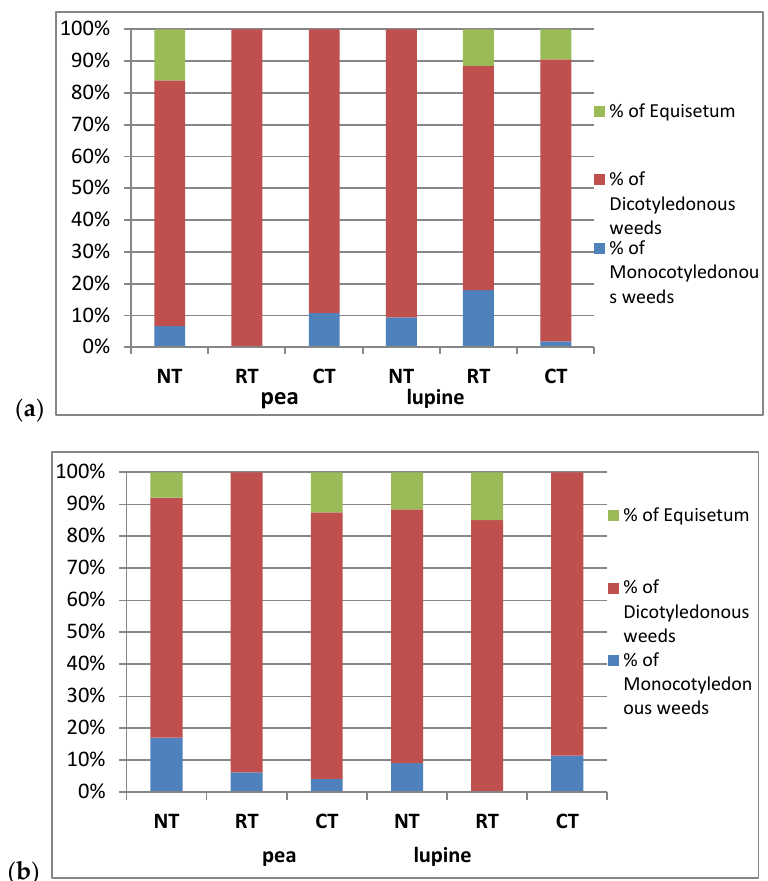
Figure 3. Percentage of monocotyledonous, dicotyledonous, and equisetum in total number of weeds in different tillage system in term: ( a ) in flowering stage (%) and ( b ) before harvest (mean for 2017–2019). NT—no-tillage, RT—reduced tillage, CT—plough tillage.